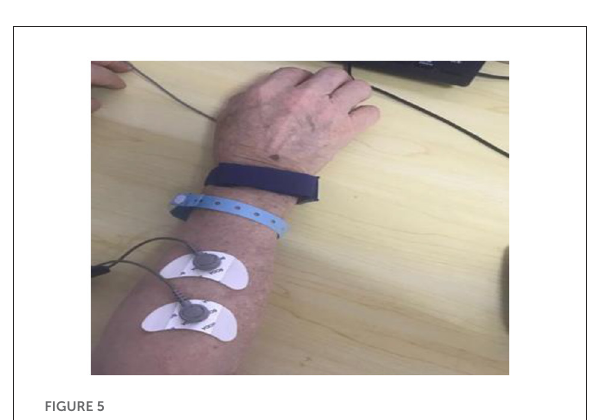
FIGURE6 Measurement of the resting motor threshold of the cerebral cortex.